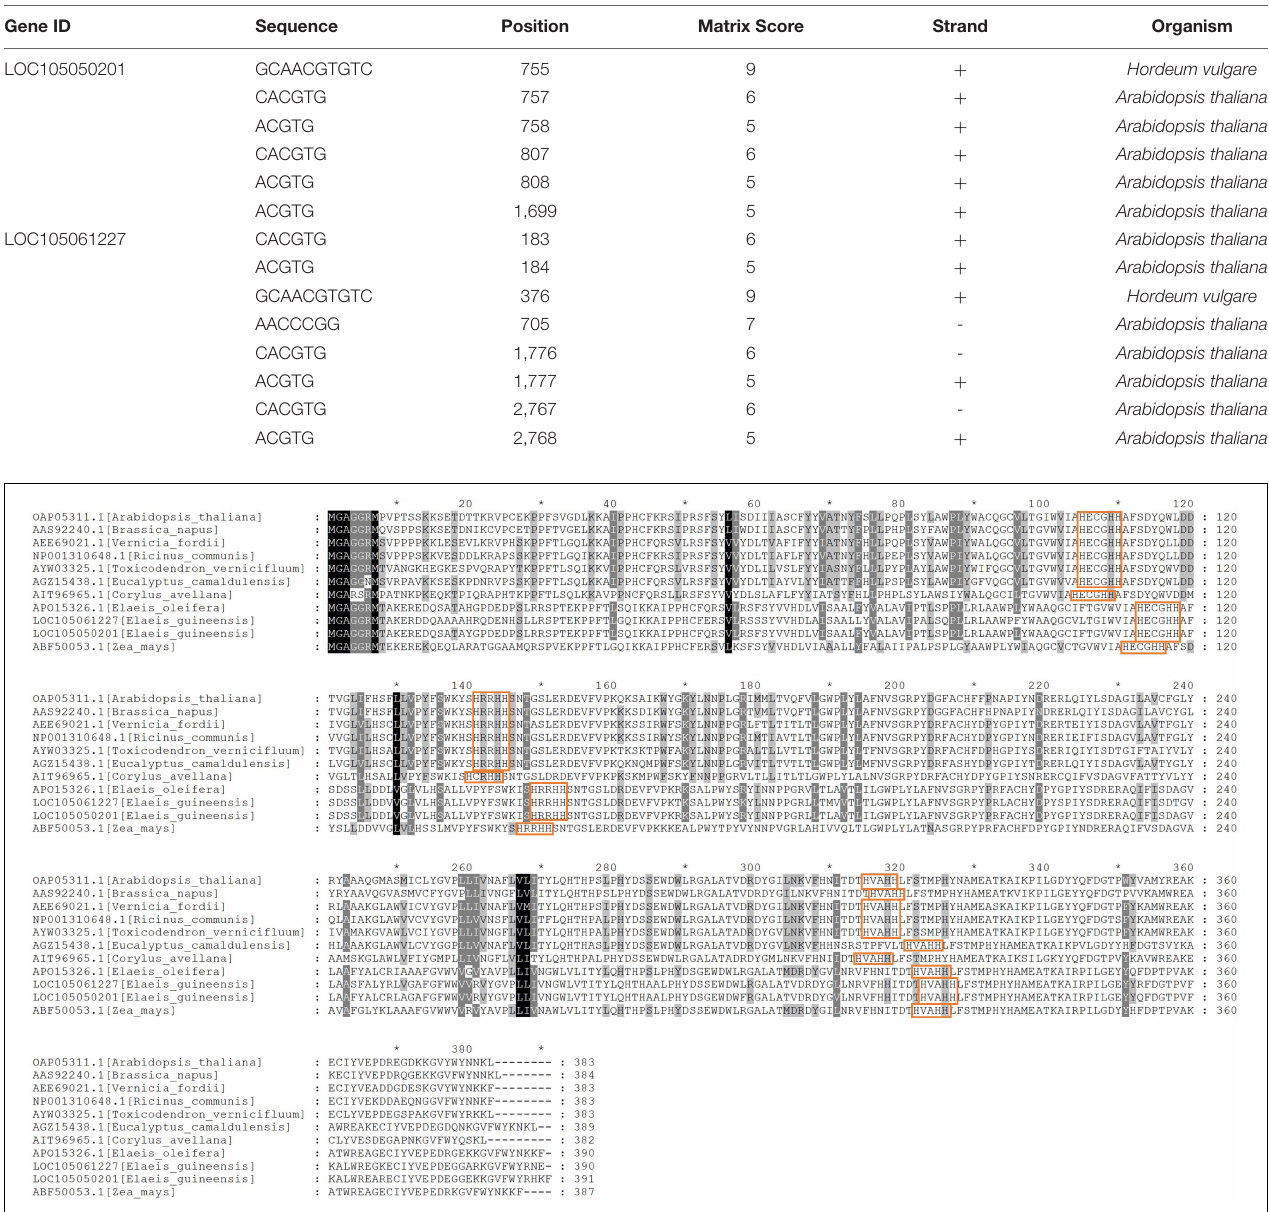
TABLE 3 | ABRE cis-acting element prediction of FAD2.